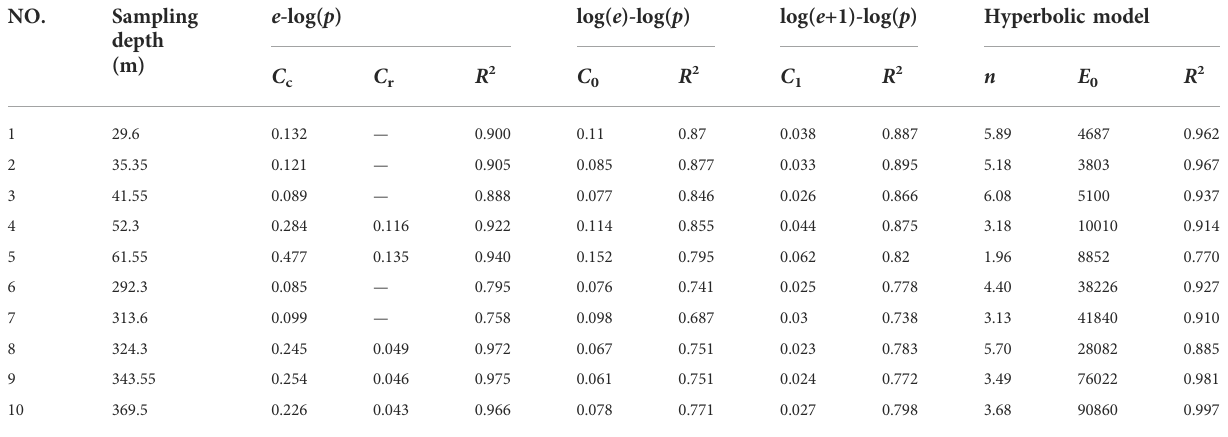
TABLE 2 The estimated parameters of the compression models for ten soil samples. NO. Sampling